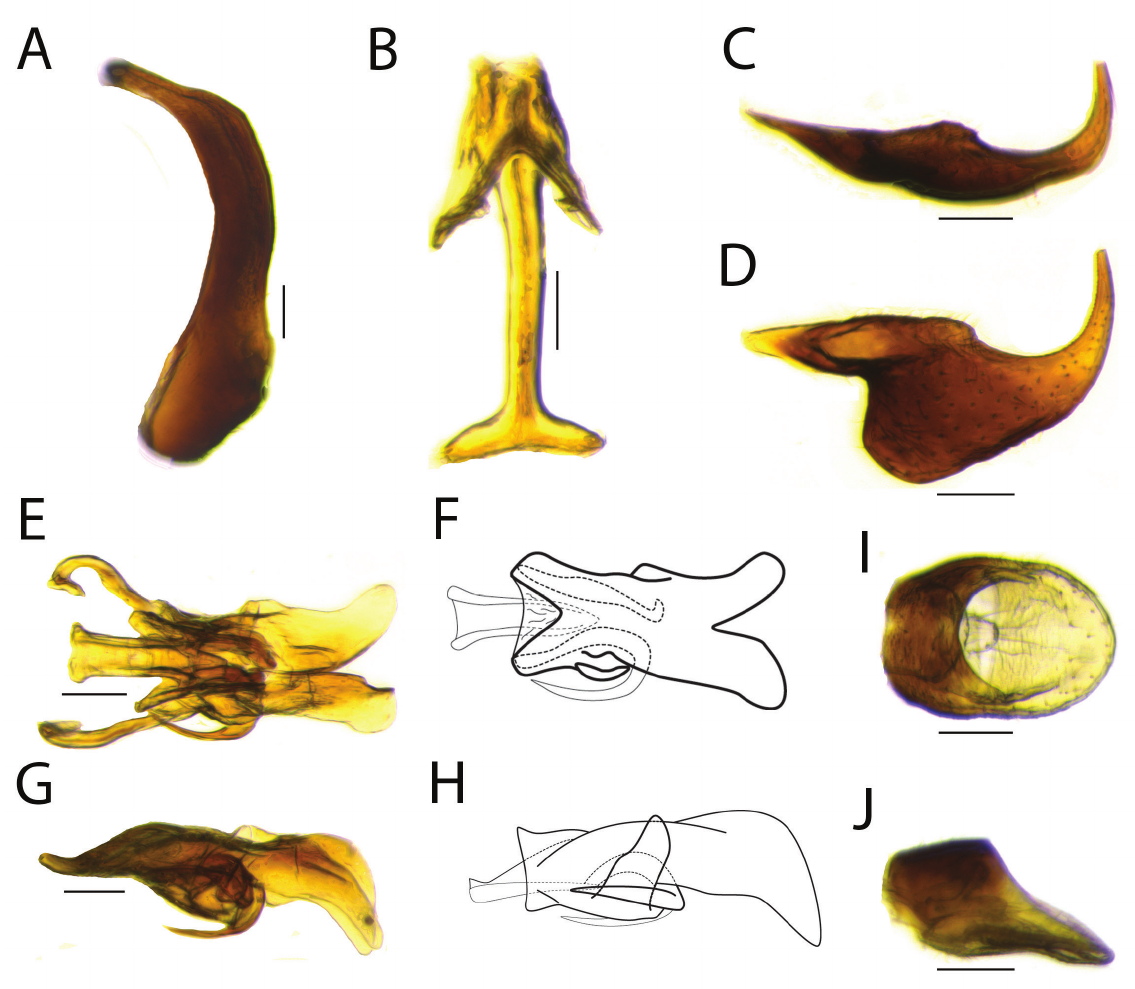
Fig. 4. Male terminalia of Bruchomorpha decorata Metcalf, 1923 (INHS). A . Pygofer, lateral view. B . Connective, anterior view. C–D . Style. C . Dorsal view. D . Lateral view. E–H . Phallus. E–F . Dorsal view. G–H . Lateral view. I–J . Anal tube. I . Dorsal view. J . Lateral view. Scale bars = 0.1